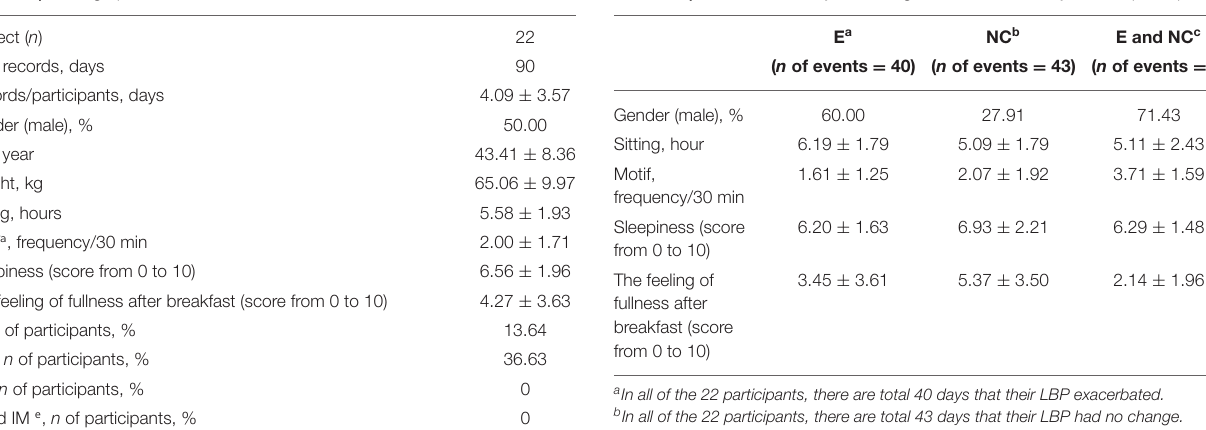
TABLE 3 | Characteristics by the change of LBP in each day from all participants.